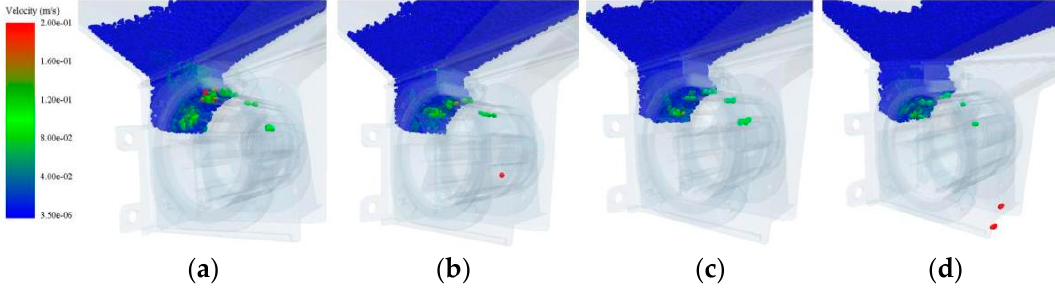
Figure 14. Migration speed comparison of wheat populations with different mod holes in same con- ditions. ( a ) Inverted-fin; ( b ) Inclined parabolic; ( c ) Bowl-shaped; ( d ) Prism-shaped.